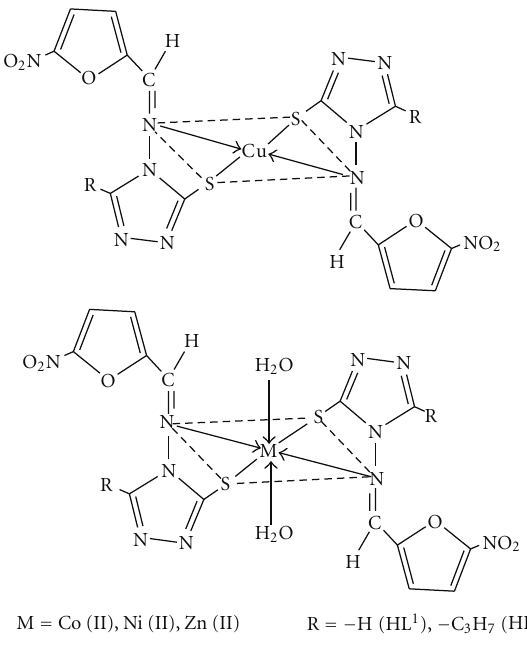
Figure 6: Structures of Metal